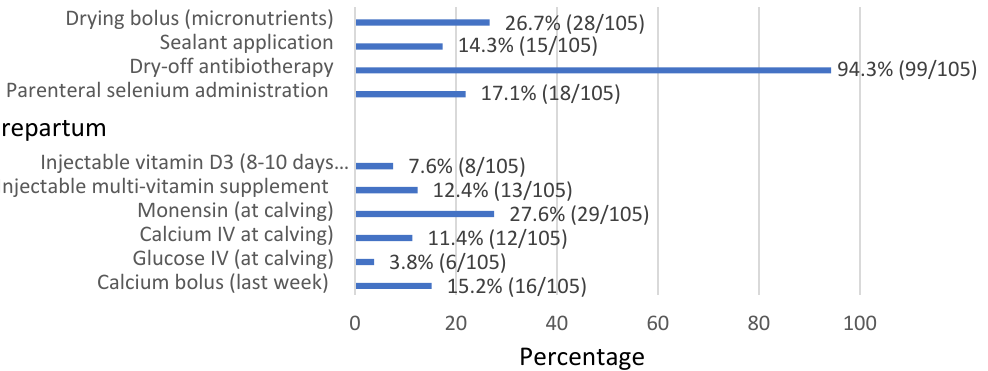
Figure 2. Main practices, micronutrient, and calcium administrations at dry-off and prepartum periods.